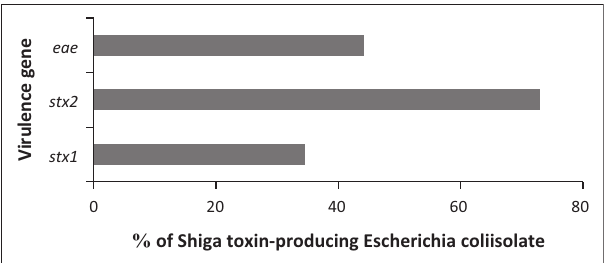
FIGURE 2: Frequency of occurrence of tested virulence genes in 71 STEC